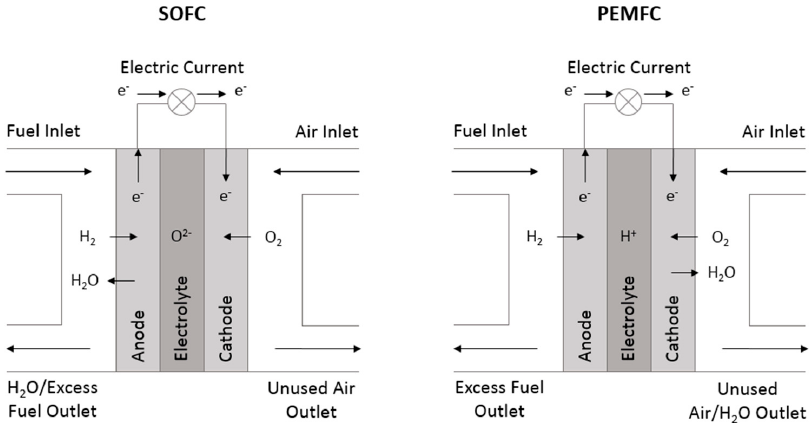
Figure 1. Comparative operative schematic of a solid oxide fuel cell (SOFC) and proton exchange membrane fuel cell (PEMFC).